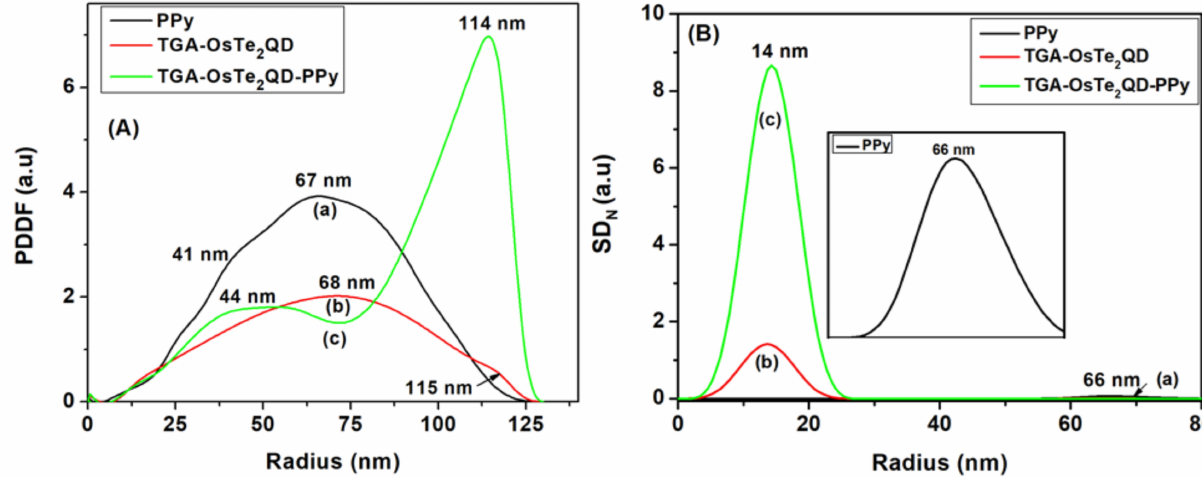
Figure 3. ( A , B ) SAXS free model PDDF and size distribution weighted by number for (a) PPy, (b) TGA-OsTe 2 QD and (c) TGA-OsTe 2